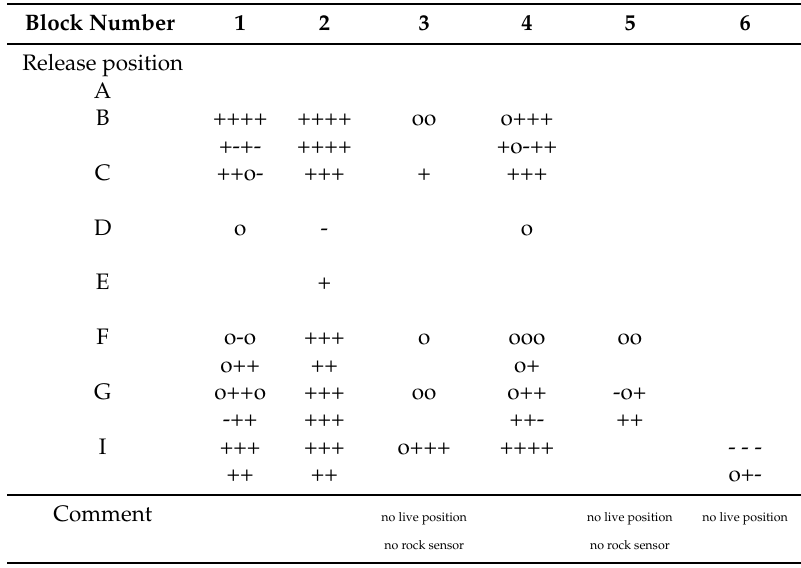
Table 3. Performed experiments for different release position combinations A–I and blocks 1–6. All trajectories were classified regarding their quality ranging from good “+”, medium “o” and poor “-”.